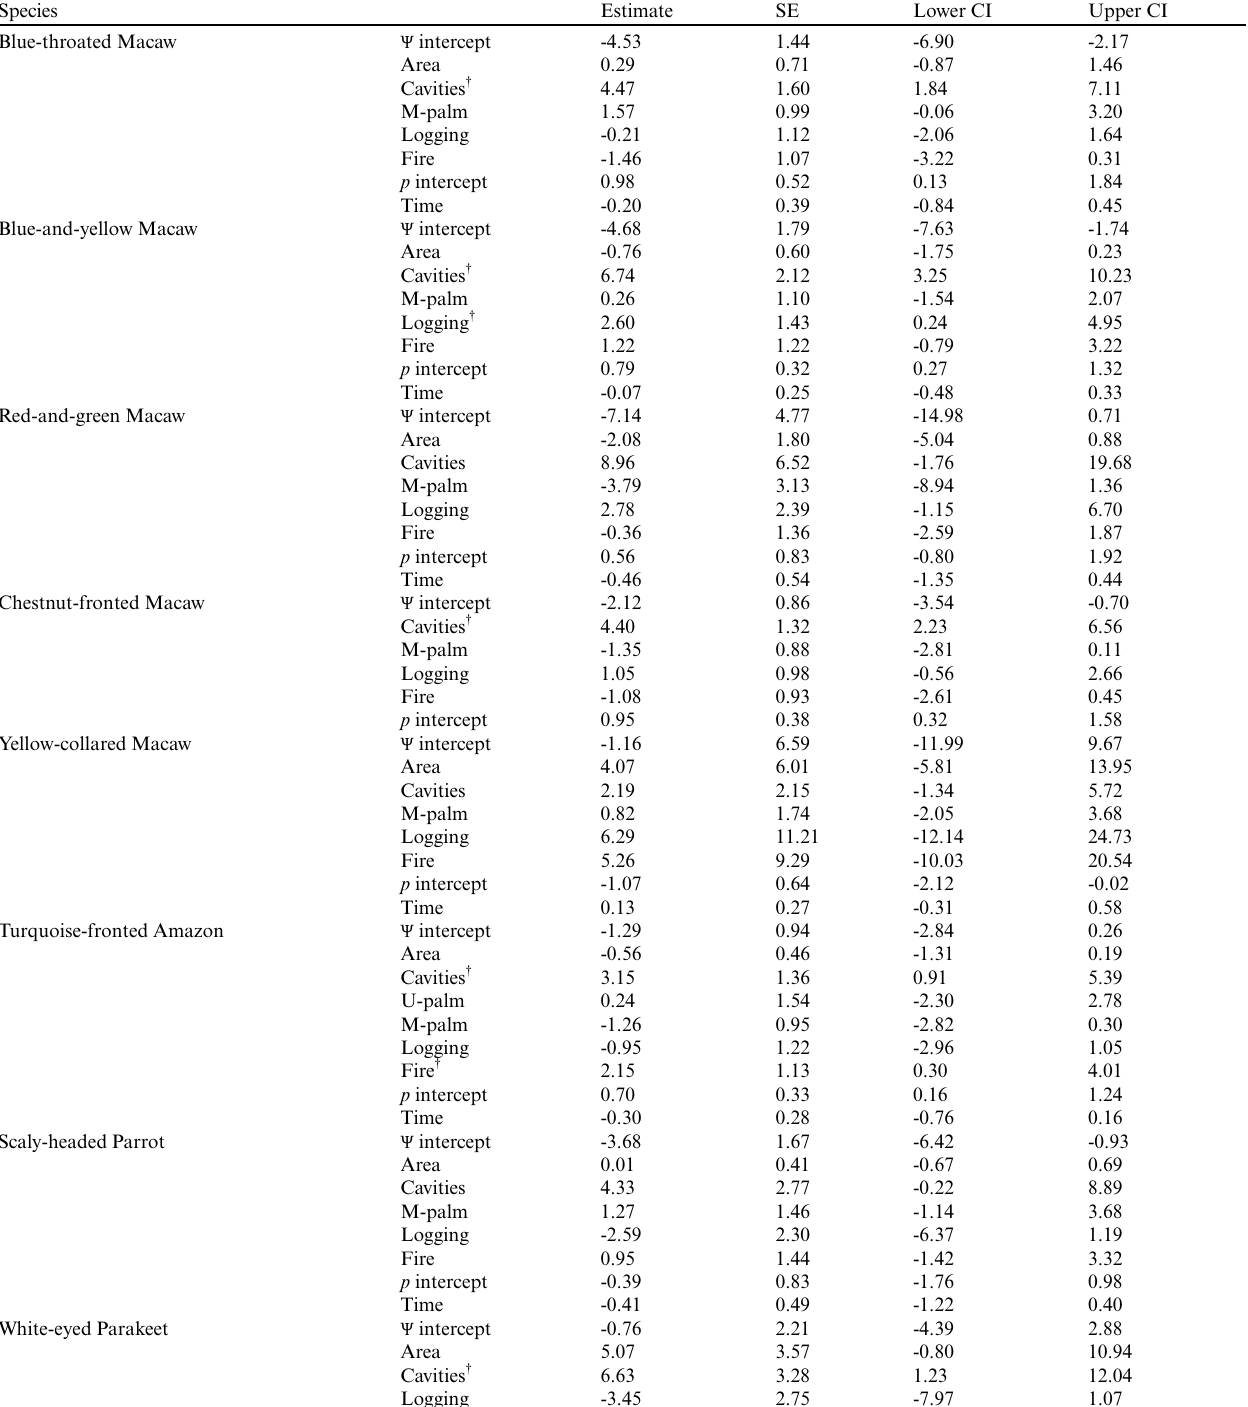
Table 4 . Model-averaged parameter estimates, standard error (SE), and 90% confidence intervals (CI) of top-ranked models ( Δ AIC < 2) for 12 parrot species within forest islands of Beni savannas, northern Bolivia. Estimates and standard error are on the logit scale. Species Estimate SE Lower CI Upper CI Blue-throated